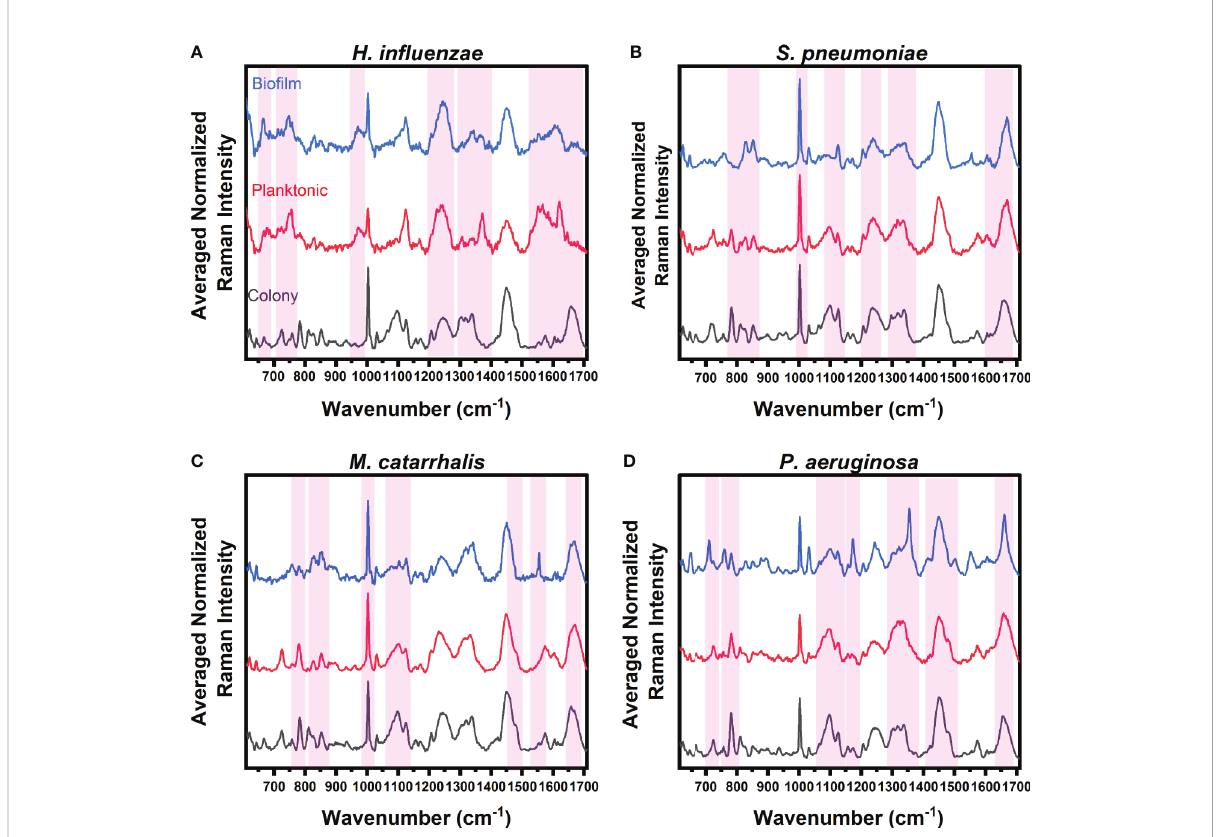
FIGURE 1 Average Raman spectra of (A) H . in fl uenzae , (B) S. pneumoniae , (C) M. catarrhalis , and (D) P. aeruginosa comparing key Raman spectral differences relating to bacterial growth under three different environments (grey: colony on agar, red: planktonic form, and blue: bio fi lms on CaF 2 substrates). The red bands highlight the wavenumbers with SMLR weighted features contributing ≥ 60% in differentiating each species ’ growth